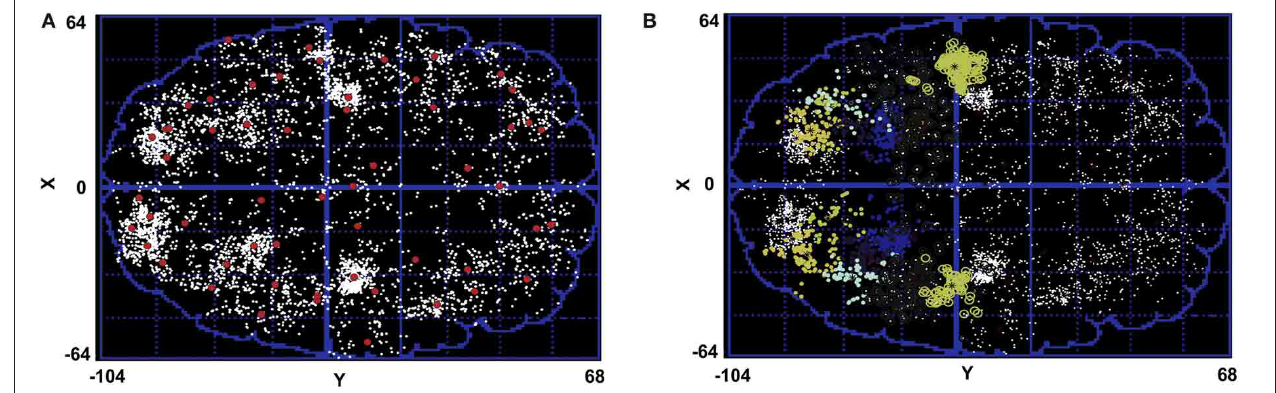
density > 10%. (B) Parietal clusters in both hemispheres. Some clusters in parietal region are so big in their physical size that they can not be attributed to only one brain region.